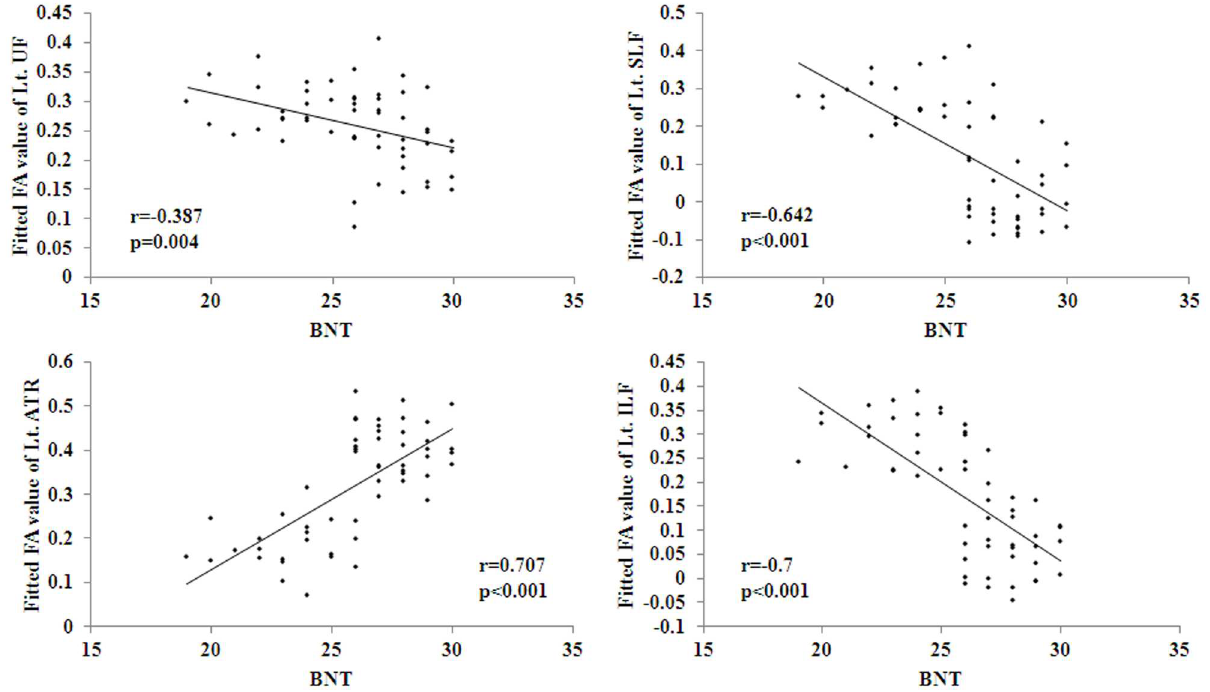
Fig 3. Significant correlations between FA values and BNT measureswere found to be negative in Lt. UF, Lt. SLF and Lt. ILF, and positive in Lt. ATR. BNT: the Boston naming test.